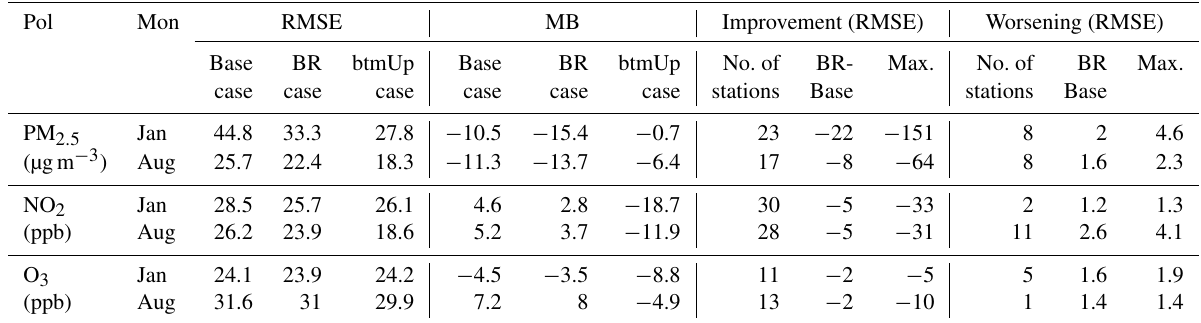
Table 3. Summary of performance statistics in the case study. Pol Mon RMSE